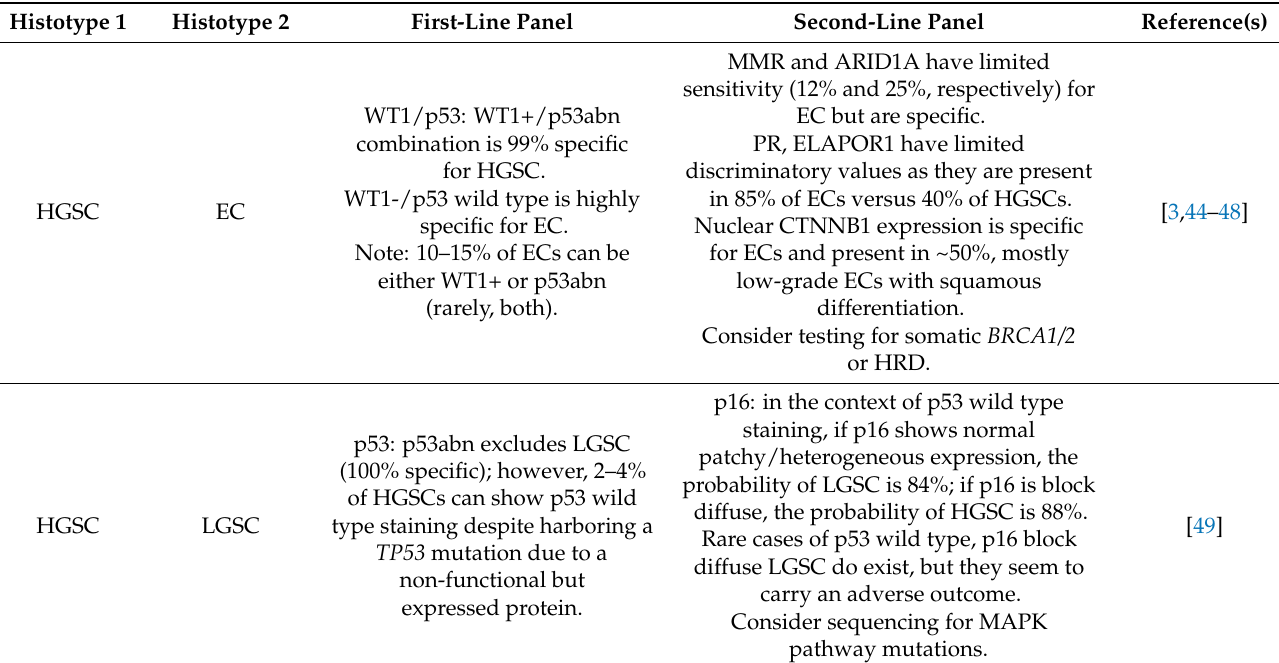
Figure 2. Four-marker immunohistochemical panel to distinguish the five principal histotypes of ovarian carcinomas: high-grade serous, low-grade serous, endometrioid, clear cell and mucinous carcinomas. PAX8 may be added as generic Mullerian marker, although there is limited sensitivity for endometrioid and mucinous carcinomas and limitations with specificity toward renal and thyroid primaries. NAPSA = napsin A. Table 2. First- and second-line immunohistochemical panels for differential diagnoses of two specific histotypes of ovarian